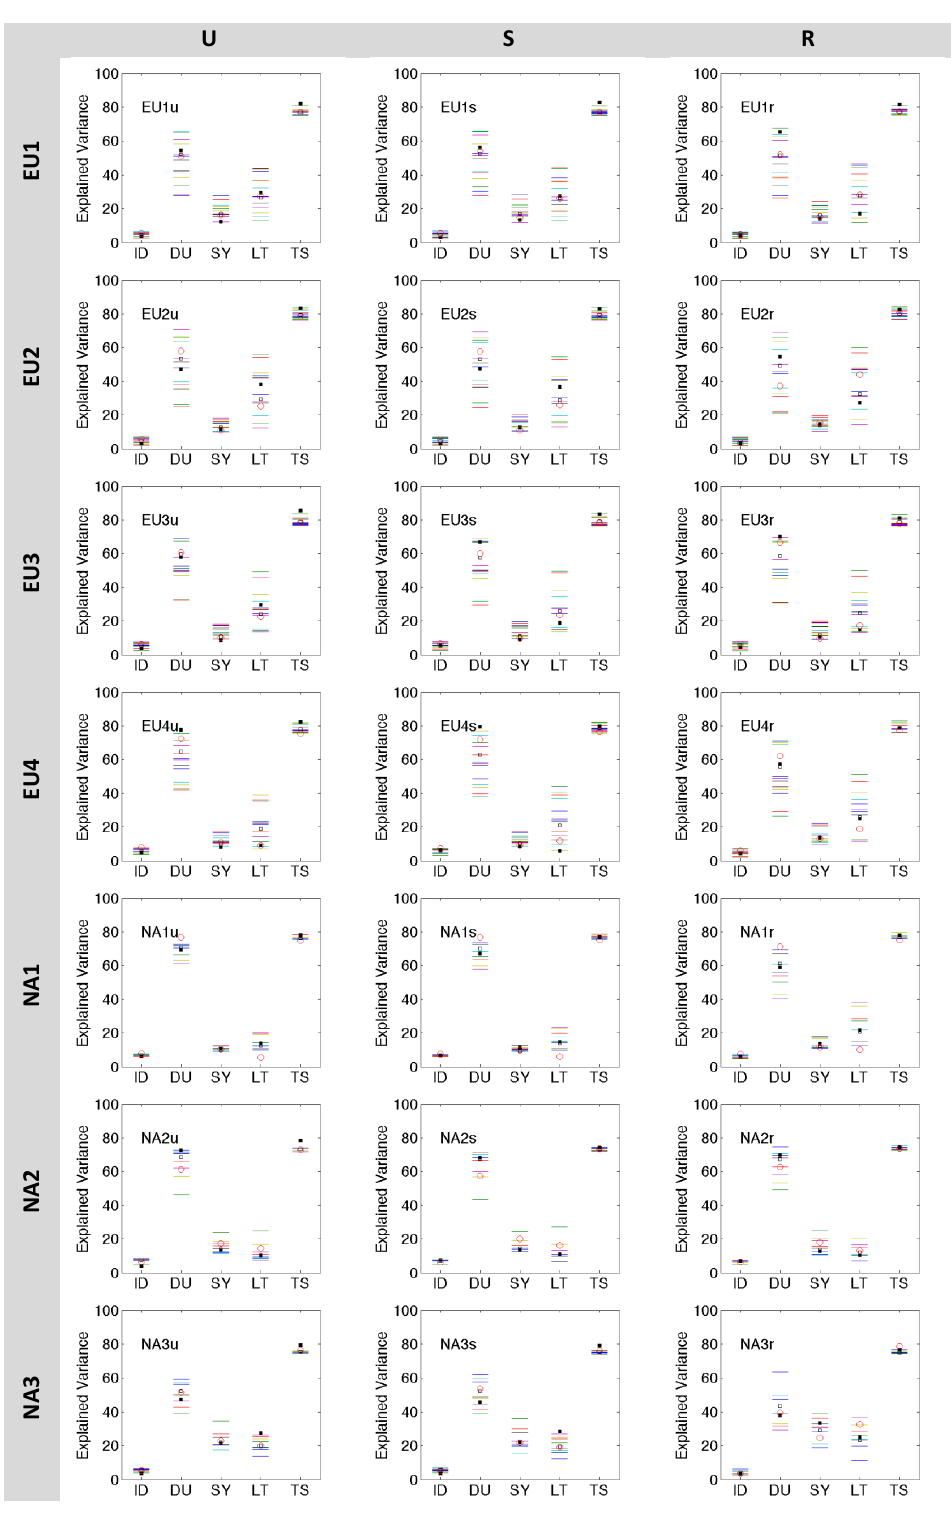
Fig. 7a. Properties of the spectrally decomposed modelled time-series of ozone, into four (ID, DU, SY, LT) components, versus their observed counterparts. Results are shown for all seven subdomains and three ozone aggregation types. For all plots, the square marker reflects the mm, the filled square the kz, the red circle the observations and the coloured lines the individual models. (a) Explained variance: the total explained variance is similar between models and observations, despite the dissimilar allocations seen for many models that tend to allocate less variance into the DU component, especially in the EU domain, and more variance to the LT